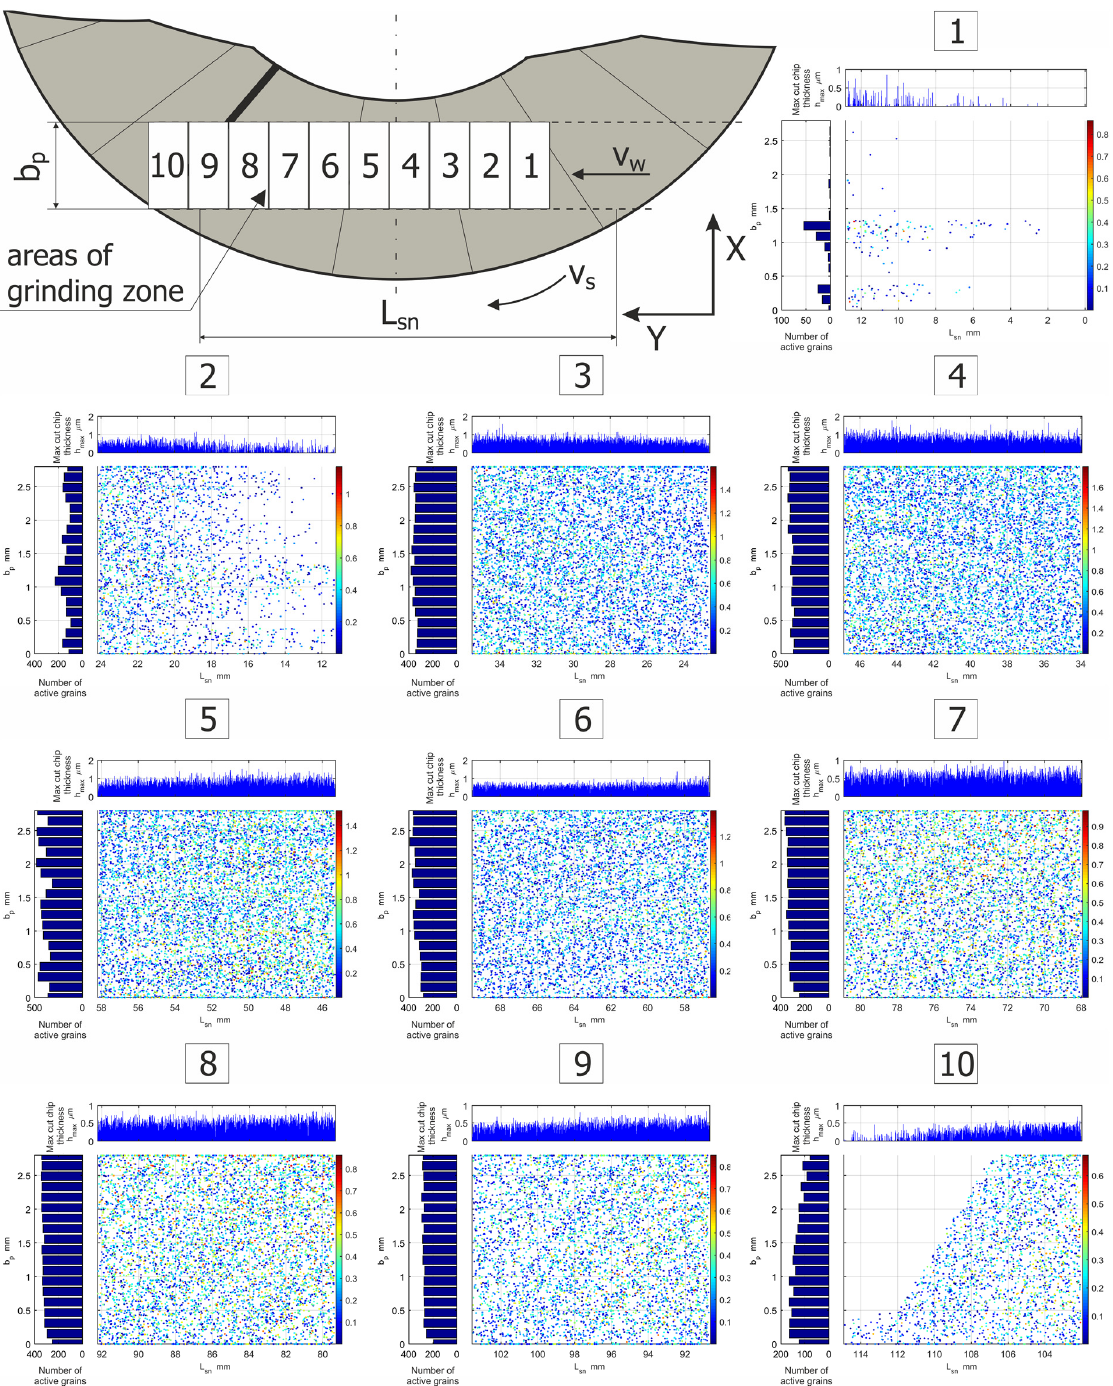
Figure 12. Visualization of the activity of abrasive grains in the micro-grinding process for different positions of the workpiece in the grinding zone.